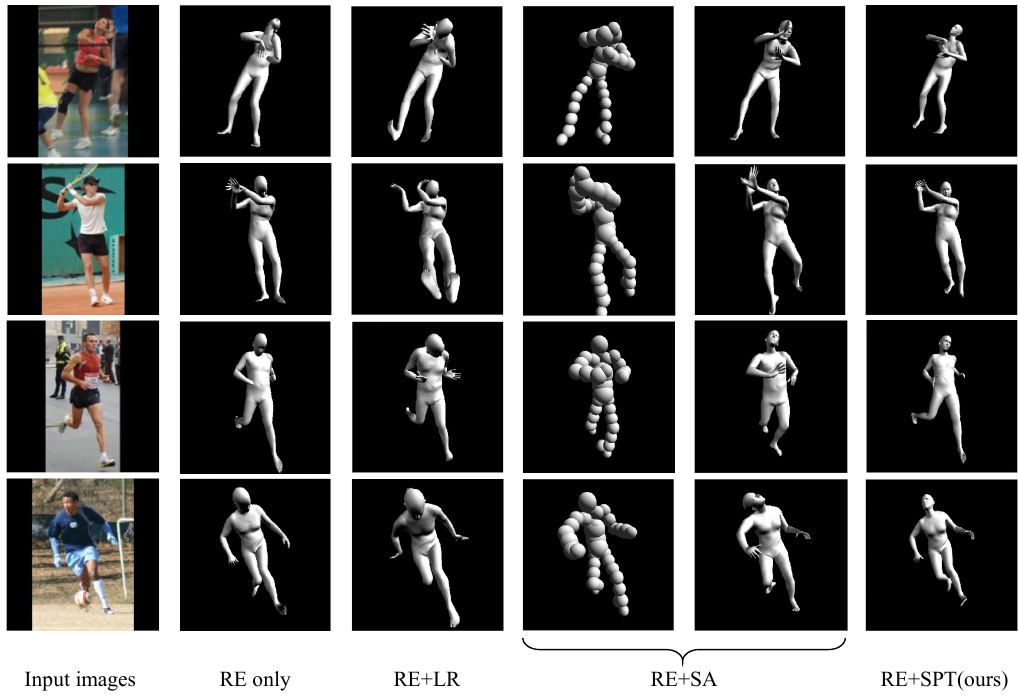
Figure 11. 3D pose estimation results by four different methods. First column: Input images. Second column: Results obtained by minimizing reprojection (RE) error of 2D joints only. Third column: Results obtained by minimizing the sum of reprojection error and Laplacian regularization (LR). Fourth column through fifth column: Results obtained by minimizing the sun of reprojection error and the intersection between spheres. Sphere Approximation (SA). Sixth column: Results obtained by our proposed